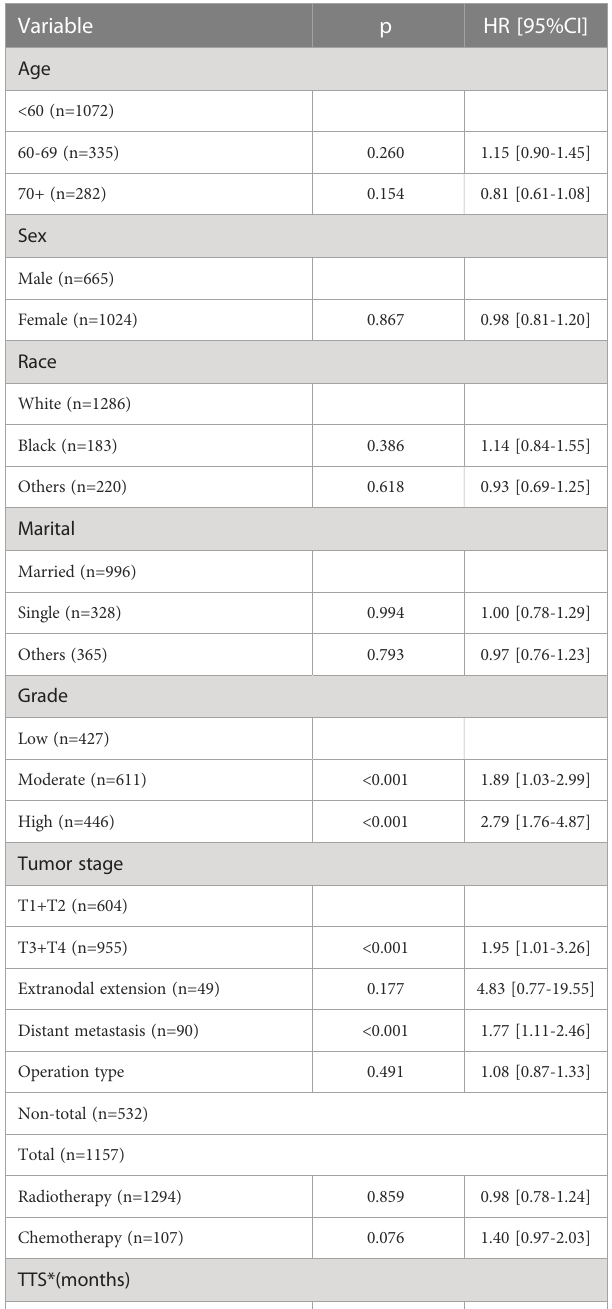
TABLE 1 Univariate cox analysis of the impact of clinicopathologic variables on disease speci fi c